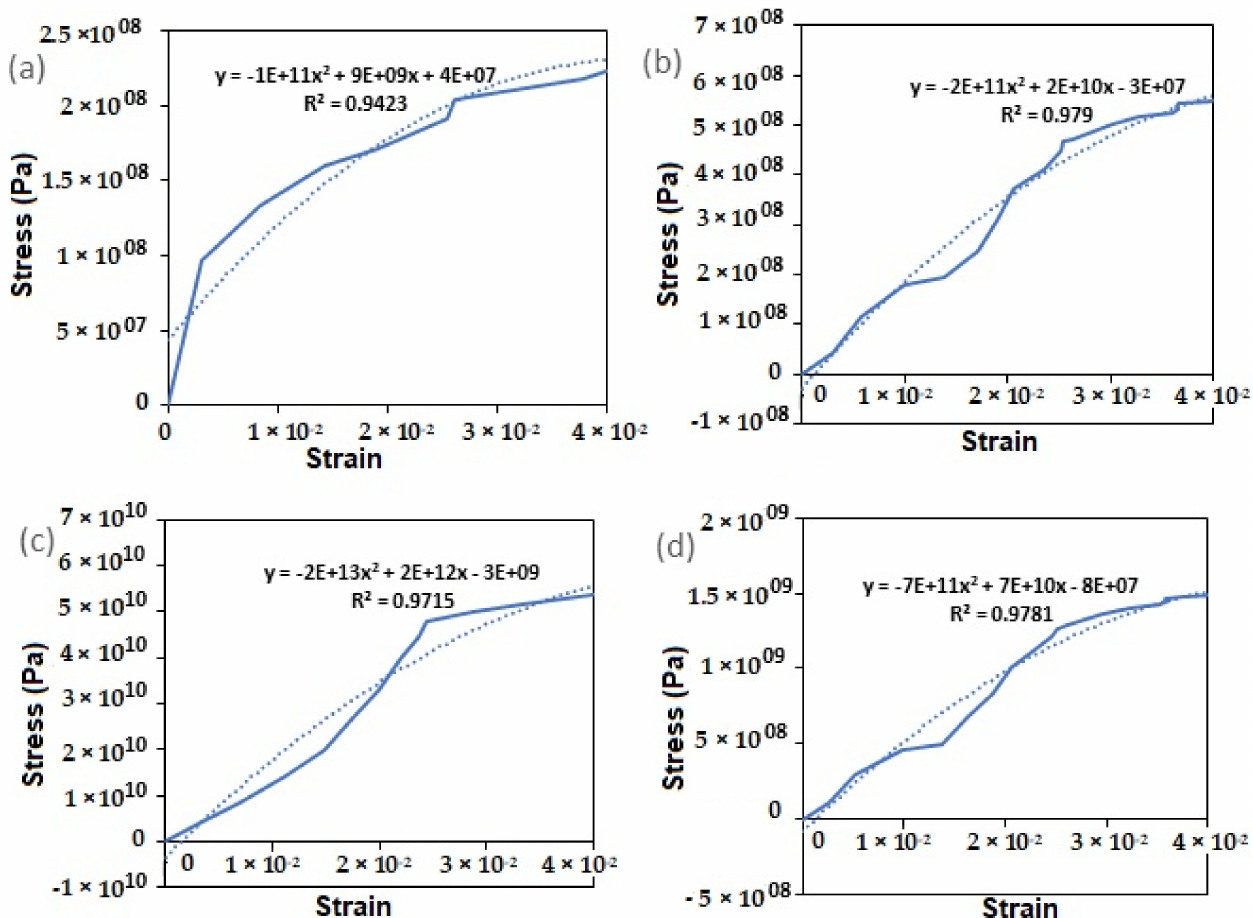
Figure 14. Stress–strain relationships for total strain in XX direction showing ( a ) elastoplastic material model, ( b ) epoxy linear elastic model, ( c ) carbon fibre linear elastic model and ( d ) Nylon PA66-Glass Fibre linear elastic